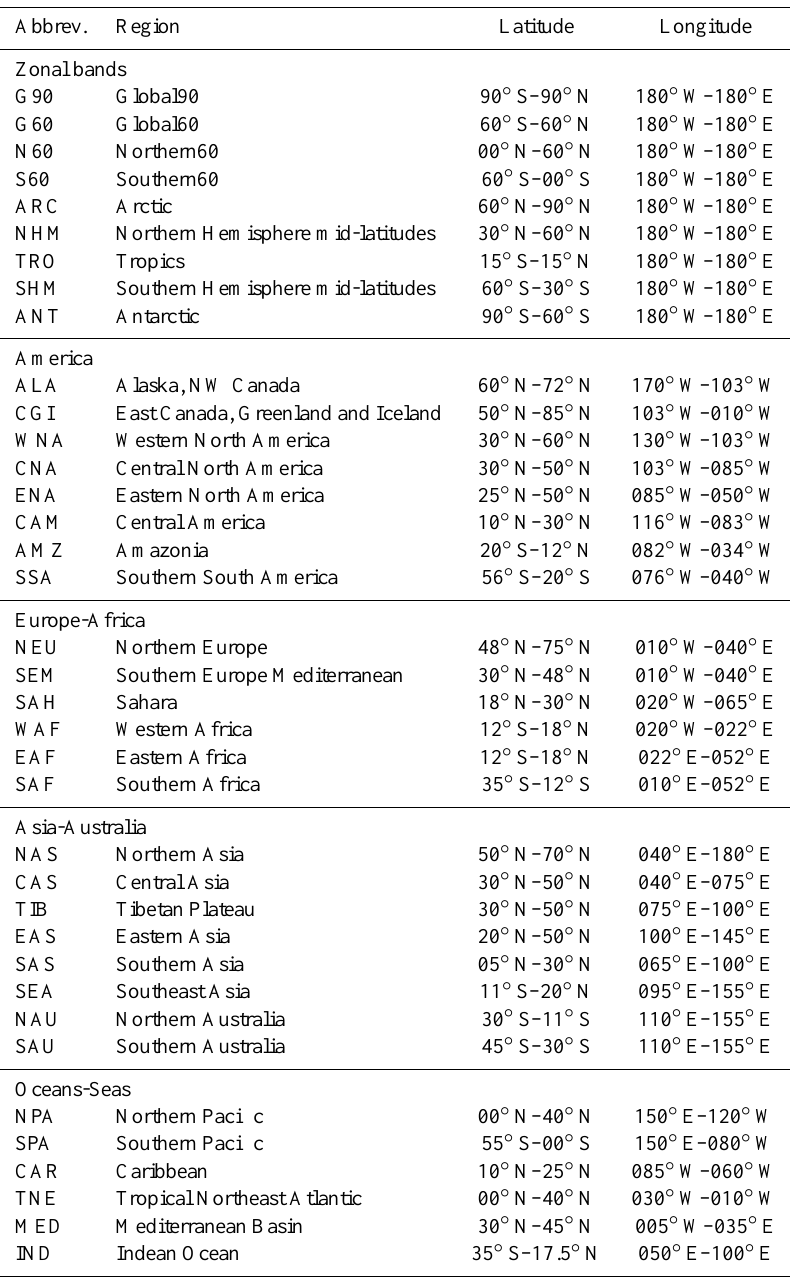
Table 1. Definition of regions used in the